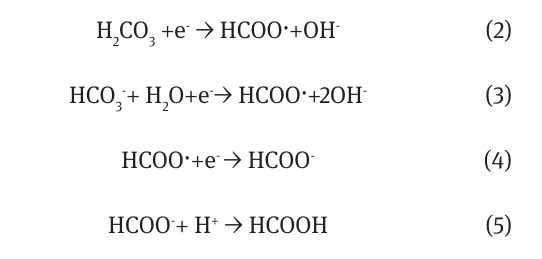
after 5h irradiation of UV (a); PSW-1, 2 (b); PSW-2